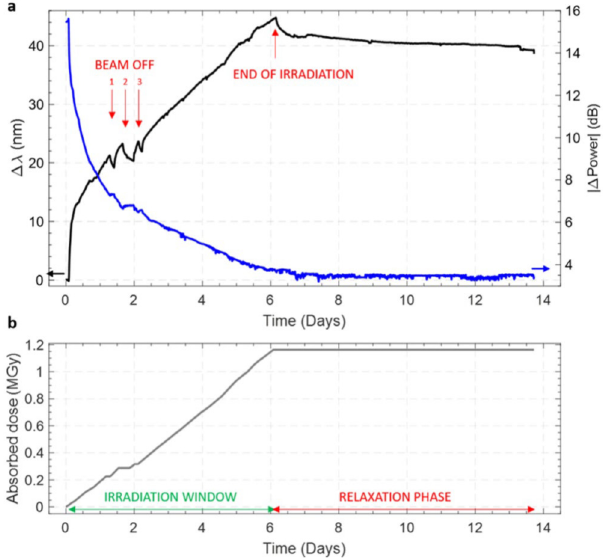
Figure 6. Proton irradiation of LPG: ( a ) resonance wavelength shift and peak depth change; ( b ) irradiation profile. © 2020 Springer Nature. Reprinted from [87] (CC BY 4.0).